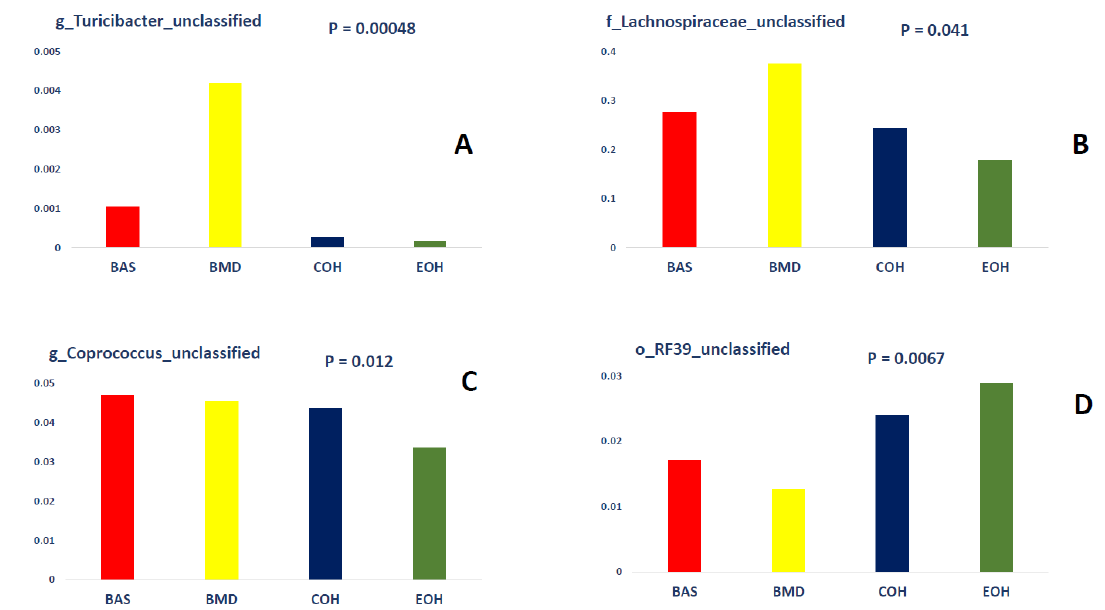
Figure 6. Illustration of the explanatory taxa for g_Turicibacter ( A ), f_Lachnospiracea ( B ), g_Coprococcus ( C ), and o_RF39_unclassified ( D ). BAS = basal diet; BMD = antibiotic diet; COH = diet supplemented with 3% coarse oat hulls; and EOH = diet supplemented with 3% extruded oat hulls.